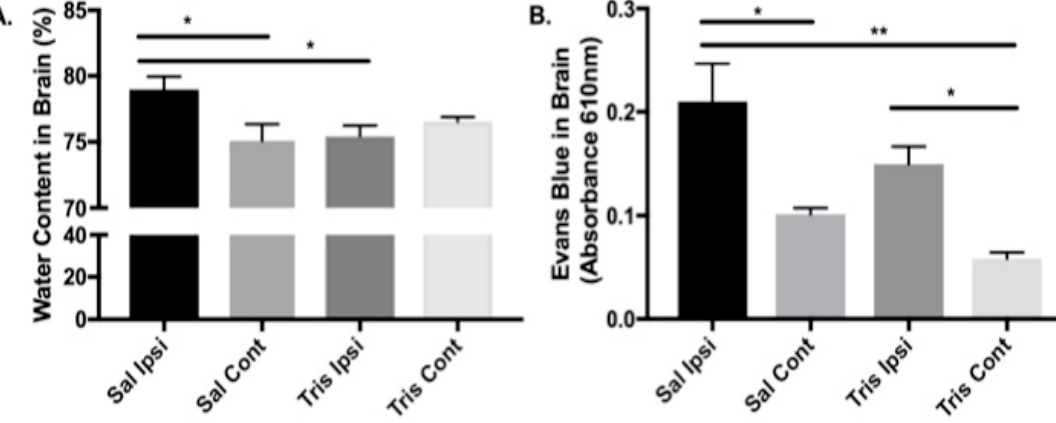
Figure 3. Percentage water content and Evans blue extravasation 24 h after tMCAO. ( A ) Water content of brain hemispheres in Tris ‐ and saline ‐ treated rats. Rats were treated with Tris ‐ HCl (0.1 g/100 g rat weight, n = 4) or 0.9% NaCl saline (Sal, n = 4) and then subjected to tMCAO 5 min after treatment. The water content in each brain hemisphere 24 h after tMCAO was calculated for each treatment. Statistics: Kruskal–Wallis test and Dunnett’s multiple comparisons post ‐ hoc test between hemispheres, Sal ipsilateral vs. Sal contralateral, * p = 0.027; Sal ipsilateral vs. Tris ipsilateral, * p = 0.035 Sal ipsilateral vs. Tris contralateral, p = n.s. ( B ) Evans blue infiltration in brains 24 h after ischemic stroke in Tris ‐ HCl vs. saline ‐ treated rats. Rats were treated with Tris ‐ HCl (0.1 g/100 g rat weight, n = 4) or 0.9% NaCl saline ( n = 4) and then subjected to tMCAO 5 min later. Evans blue infiltration content was obtained by measuring absorbance at 610 nm. Statistics: one ‐ way ANOVA, Tukey’s multiple comparison post ‐ hoc test between hemispheres: Sal ipsilateral vs. Sal contralateral, * p = 0.014; Sal ipsilateral vs. Tris contralateral, ** p = 0.001; Tris ipsilateral vs. Tris contralateral, * p = 0.038; Sal contralateral vs. Tris ipsilateral, n.s.; Sal ipsilateral vs. Tris ipsilateral, n.s.; Sal contralateral vs. Tris contralateral, n.s. Error bars represent the standard error of the mean; n.s., not significant.